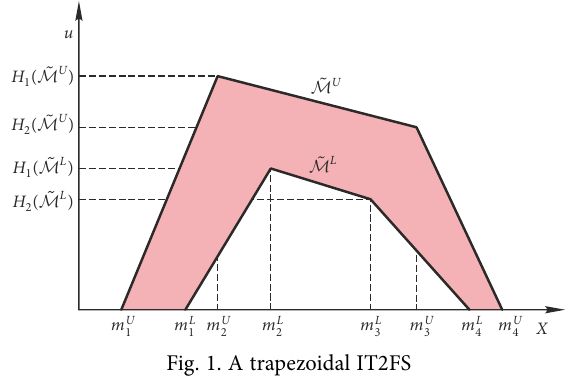
Fig. 1. A trapezoidal